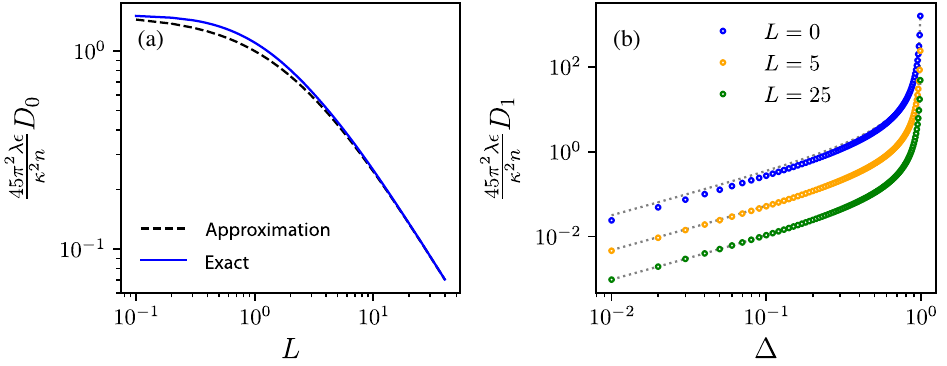
FIG. 6. (a) The noninteracting part of the diffusivity, D 0 . The dashed line is the approximation [Eq. (87)] developed in the text. (b) The interacting part of the diffusivity, D 1 . The dotted lines correspond to the approximate expression [Eq. (88)] evaluated at the corresponding value of L